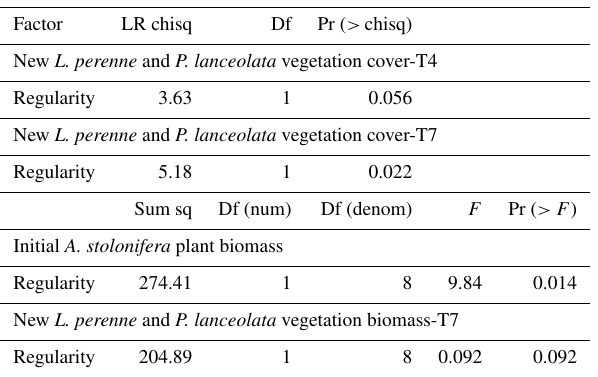
Figure 3. Shannon’s diversity (SD) of the soil fauna functional groups in each node of all mesocosms across time (inoculation time not included due to the consideration of initial diversity of the in- oculum cannot represent the actual diversity of the surviving soil fauna). Line here indicated the predicted Shannon’s diversity for a mean regularity across time (days after inoculation time). Black points refer to the species diversity in the central nodes, while grey nodes refer to species diversity in the other nodes in the mesocosms. Table 2. Effect of plant spatial regularity on accumulated above- ground biomass of initial A. stolonifera plants and new L. perenne and P. lanceolata vegetation cover measured at the fourth and sev- enth measurement time (i.e. 6 and 9 weeks after sowing the seeds), and its aboveground biomass measured at the seventh measurement time. Negative binomial generalized linear models were fit for plant cover by the subsequent vegetation of L. perenne and P. lanceolata . Linear models were fitted for initial A. stolonifera plant biomass and biomass of the subsequent